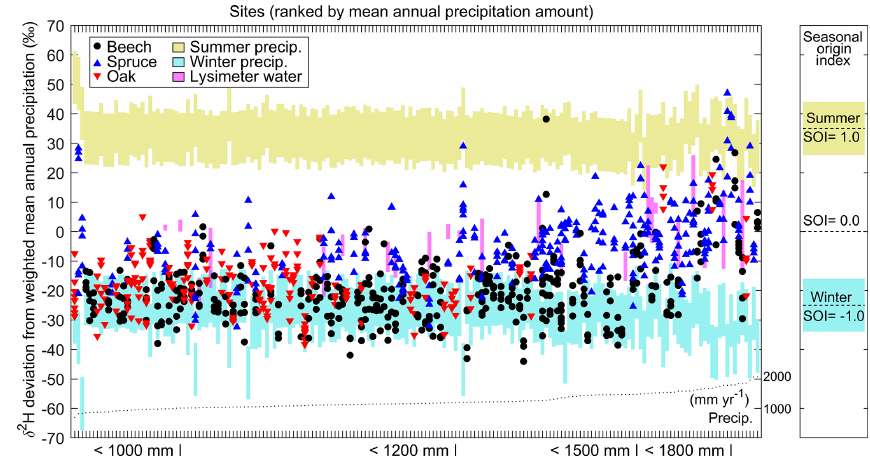
Figure 2. Isotope ratios of xylem water and lysimeter soil water, compared to site-specific seasonal isotope cycles in precipitation. Fractionation-compensated isotope ratios for xylem and soil lysimeter water are plotted as deviations from each site’s volume-weighted annual precipitation δ 2 H for the two years prior to the summer 2015 sampling. Typical isotope values for summer and winter precipitation are shaded (see methods). Magenta bars show the δ 2 H range of lysimeter soil water in depth profiles. Sites are ranked by mean annual pre- cipitation amount (see dotted black line and labels below the horizontal axis). The panel on the right depicts how isotope values translate to seasonal origin index values. Trees in all but the wettest sites mostly use water that isotopically resembles winter precipitation (i.e., negative